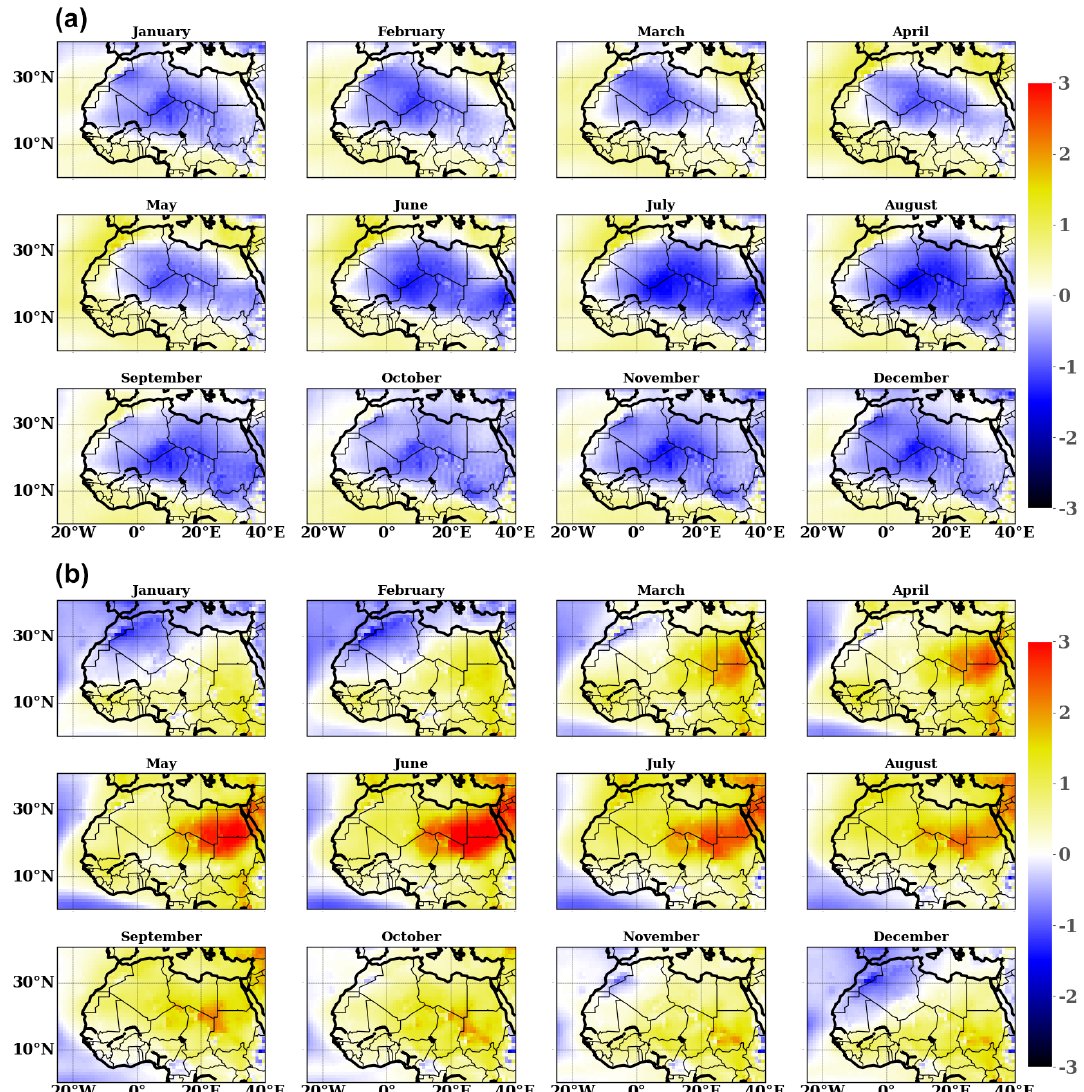
Figure 5. Climatology of monthly bias temperature over the Sahara region during 1993–2016 between (a) SEAS5 and ERA5 and (b) MF7 and ERA5. The bias is computed using daily temperature at 00:00 and 12:00UTC. The computation was made using the ensemble mean for forecast models. The color bar indicates the bias value in kelvins. The y axis indicates the latitudes and x axis the longitudes of our